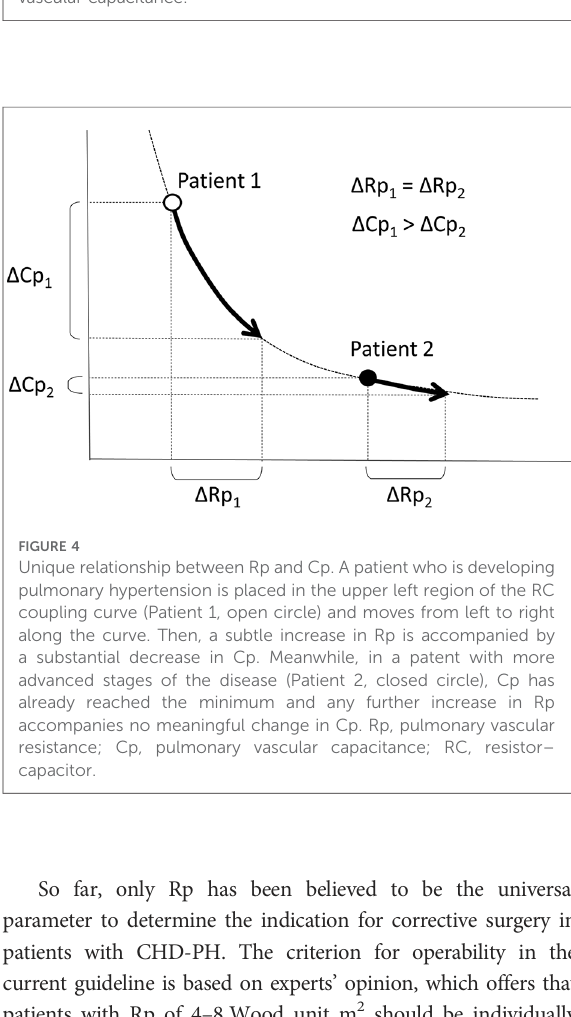
FIGURE 5 RC coupling among infants with ventricular septal defect and pulmonary hypertension; patients with excessively increased pulmonary blood fl ow are distributed in the upper left part of the RC coupling curve (open circle), whereas patients with modestly increased pulmonary blood fl ow are distributed in the lower right part of the curve (closed circle), which suggested that a subtle change in Rp gives a substantial change in Cp in patients with excessive pulmonary blood fl ow. Rp, pulmonary vascular resistance; Cp, pulmonary vascular capacitance; RC, resistor – capacitor.